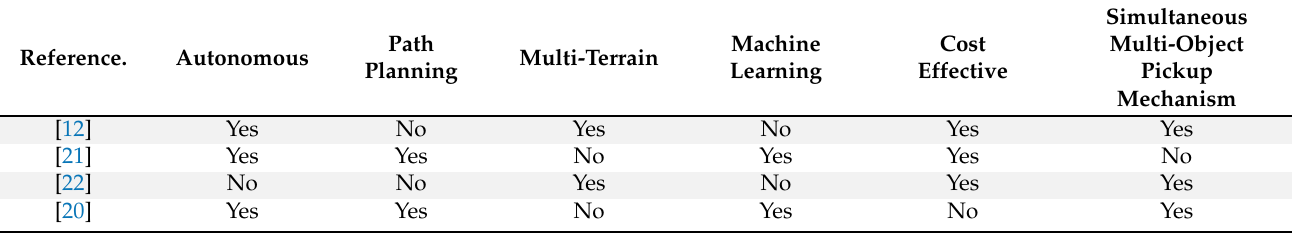
Table 1. Survey of Previous